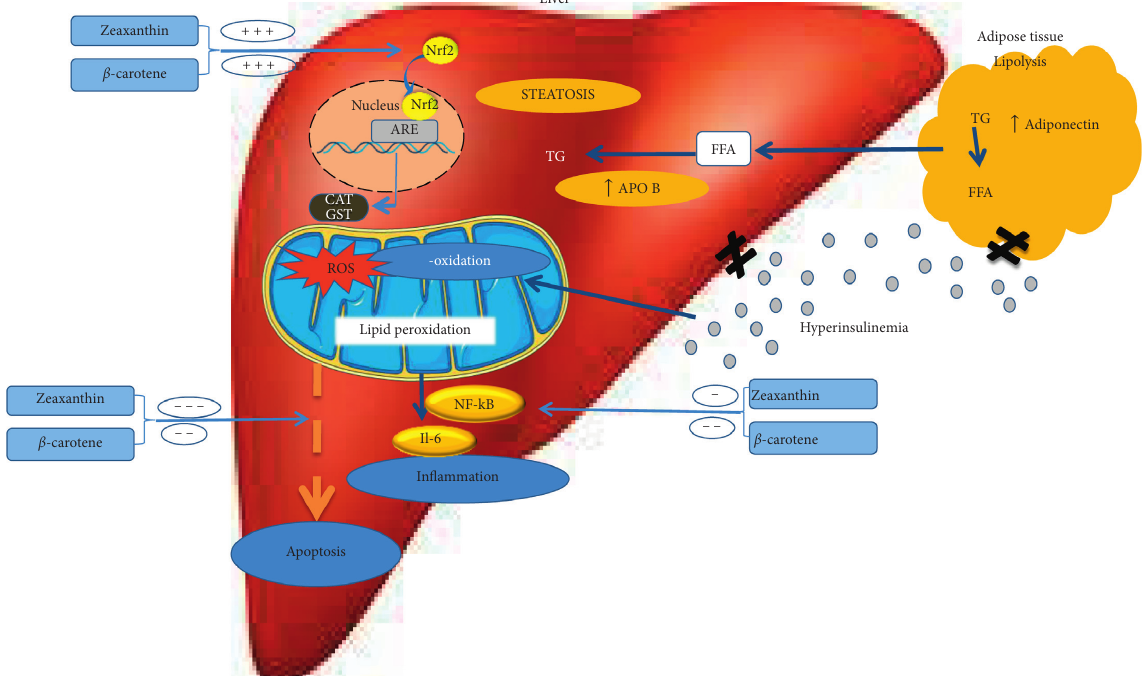
Figure 7: Mechanism of action of D. salina microalgae in alleviating age-related hepatic streatosis. ARE :antioxidant response element; CAT: catalase; FFA: free fatty acids; GST: glutathione-S-transferase; IL-6: interleukin-6; NF- κ B: nuclear factor kappa beta; Nrf2: NF-E2- related factor 2; ROS: reactive oxygen species; TG: